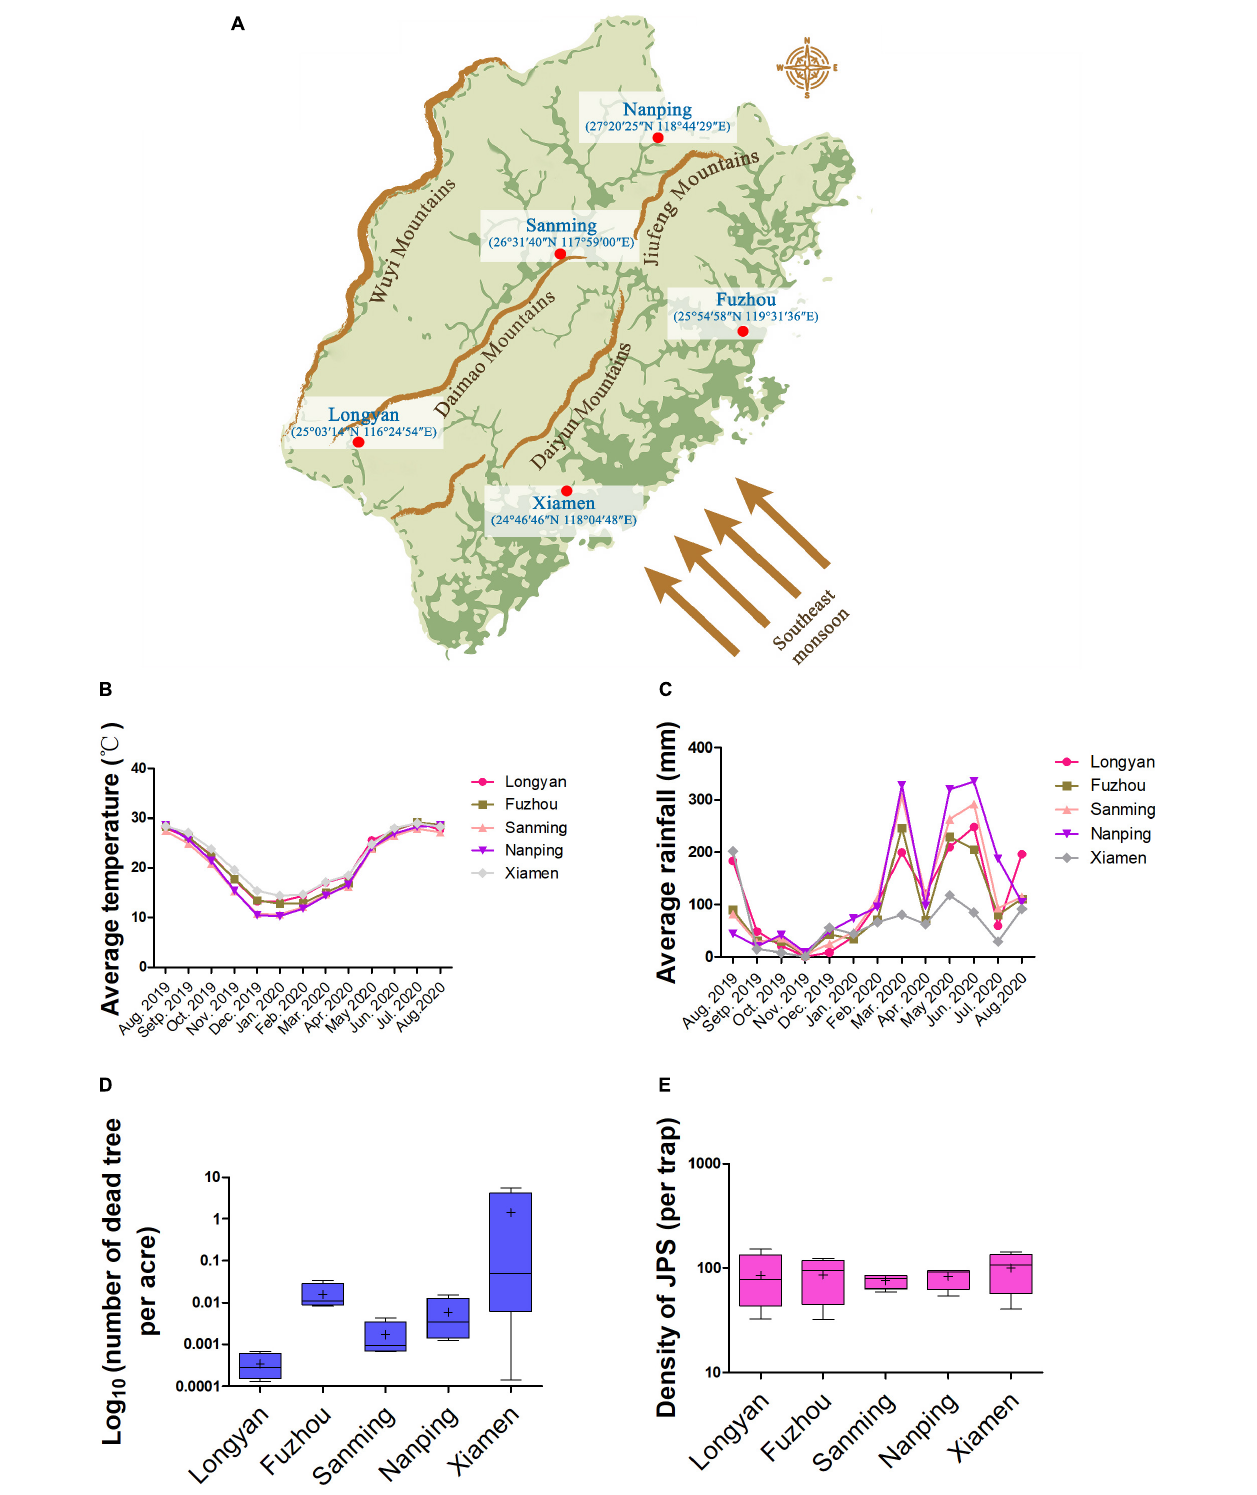
FIGURE 1 | Geographical information and epidemic situation of PWD in sample areas. (A) Illumination of basic geographical information of the five sample areas (Fuzhou, Nanping, Sanming, Xiamen, and Longyan). Average temperature (B) and rainfall (C) were recorded from August 2019 to August 2020. Annual data of fatality rate and density of JPS (Japanese Pine Sawyer) were collected from 2016 to 2020 in the five sample areas and are plotted in (D) and (E) , respectively. Each box represents the largest and lowest value, with bars representing one standard deviation (SD). “+” represents the mean value.